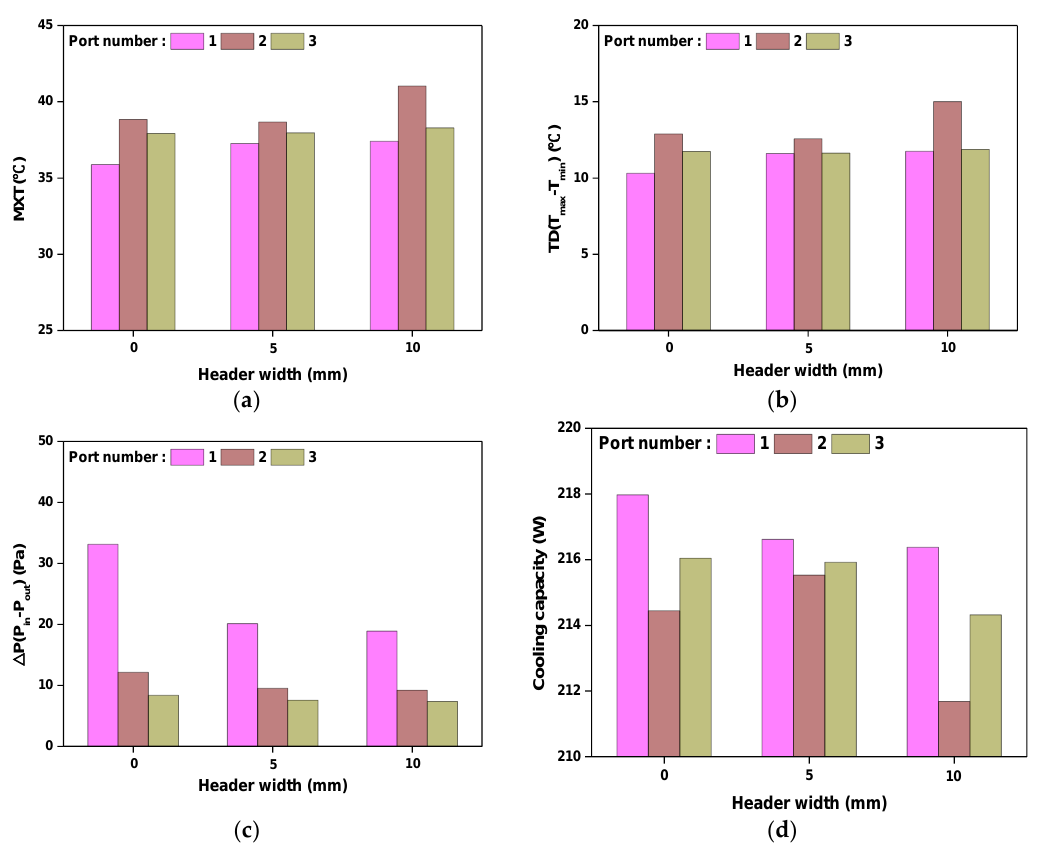
Figure 7. Comparison of cooling performance according to header width: ( a ) MXT of battery for different header width; ( b ) TD of battery for different header width; ( c ) Pressure drop for different header width; ( d ) Cooling capacity for different header width.